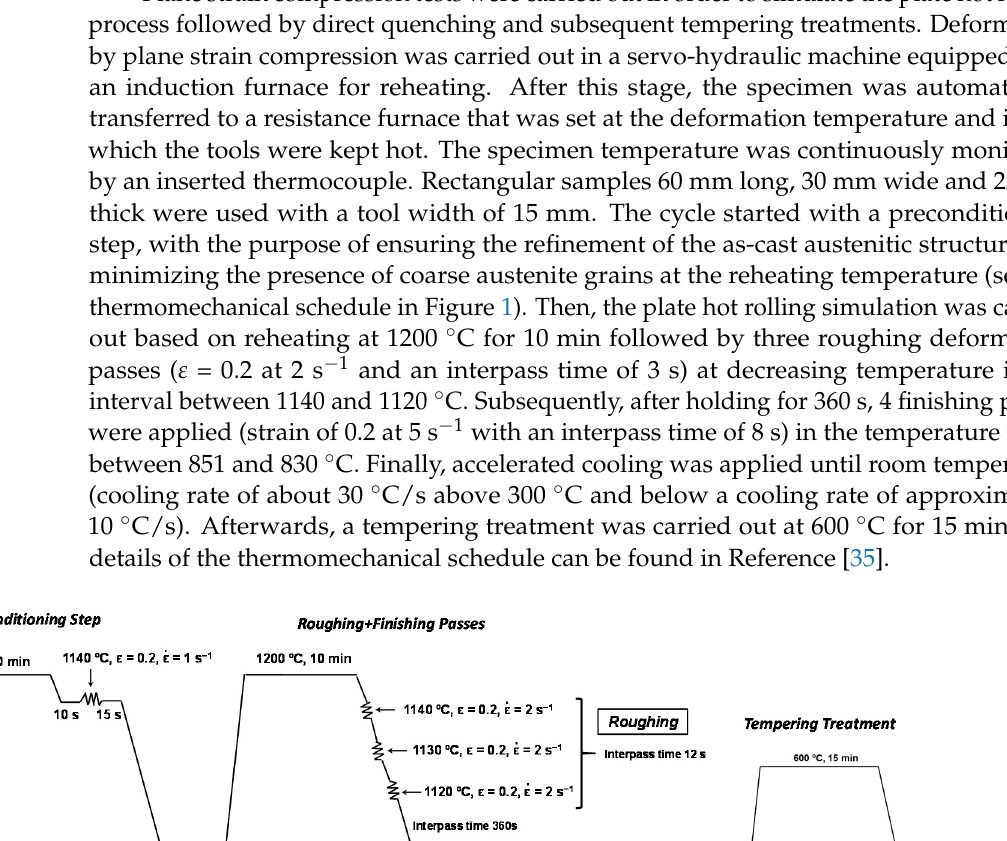
thickness was associated with the geometry and friction of the sample/tool [36]. Therefore,